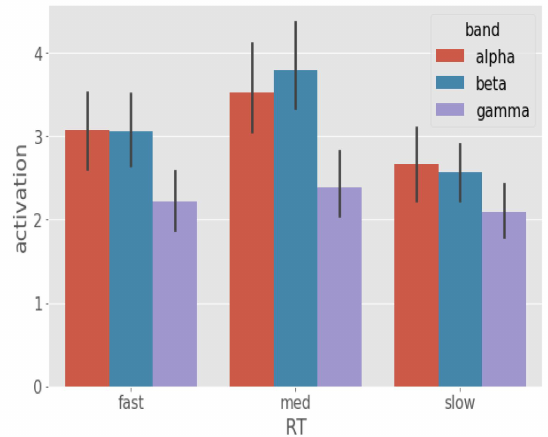
Figure 8. Band activation (95% CI) comparison between the RT categories. Band activation was acquired by averaging the activation scores over 64 electrodes of α , β , and γ frequency bands. From these band activations, we observe that α and β bands are the primary correlates of RT whereas the effect of γ band is